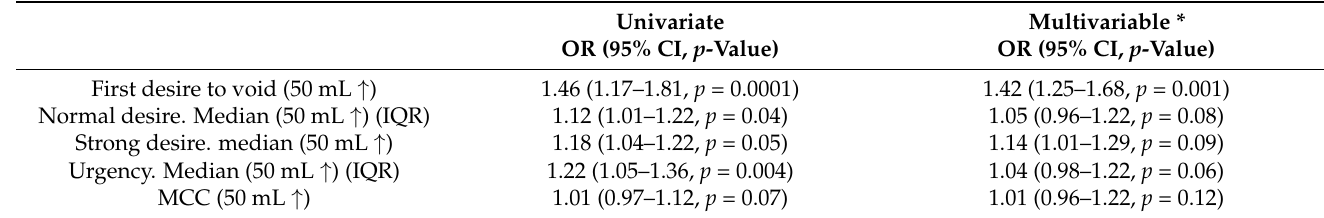
Table 2. Association between bladder sensation volumes and BOO according to univariate and multivariate logistic regression